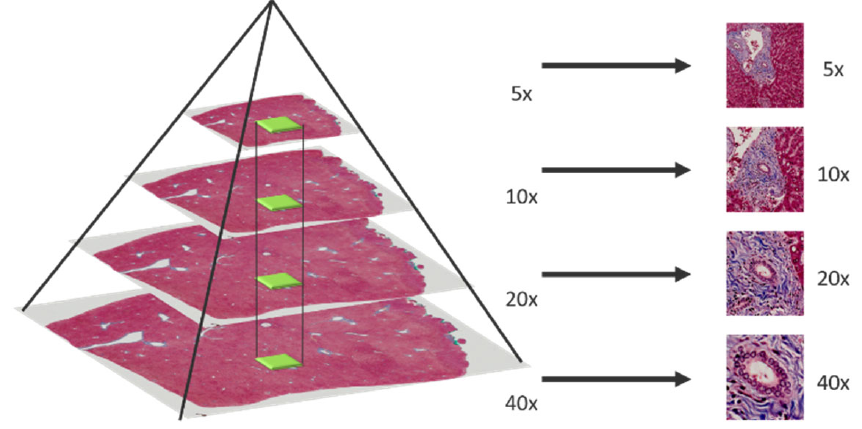
Figure 2. Multi ‐ magnification patches generated by sliding window.